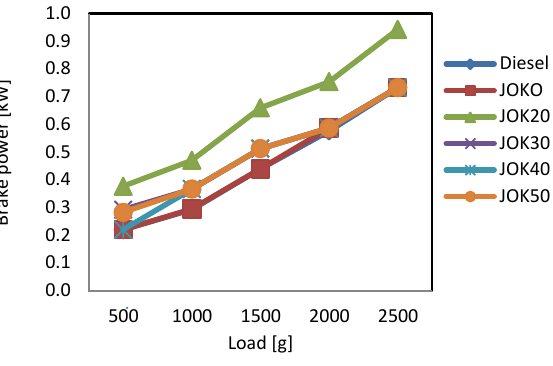
Fig. 2. Variation of BP for JOK blends with increase in load